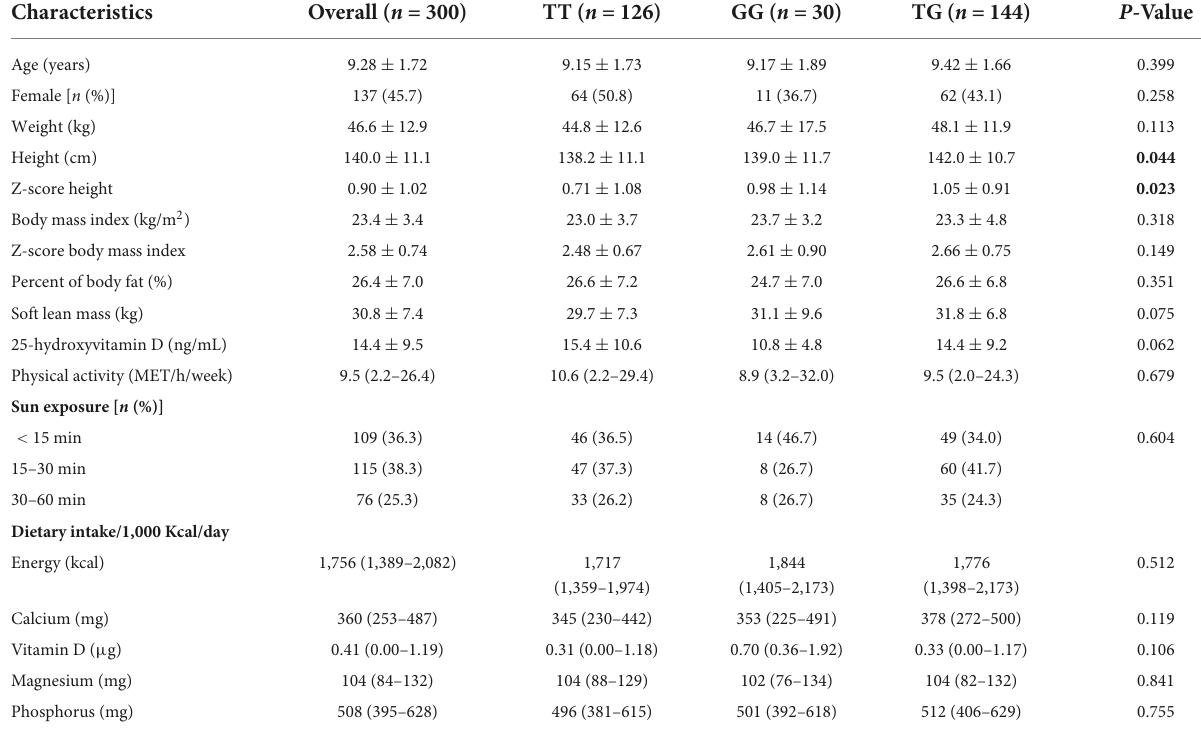
TABLE 1 Baseline characteristics of participants according to GC-rs2282679 genotypes in overweight and obese children and adolescents.